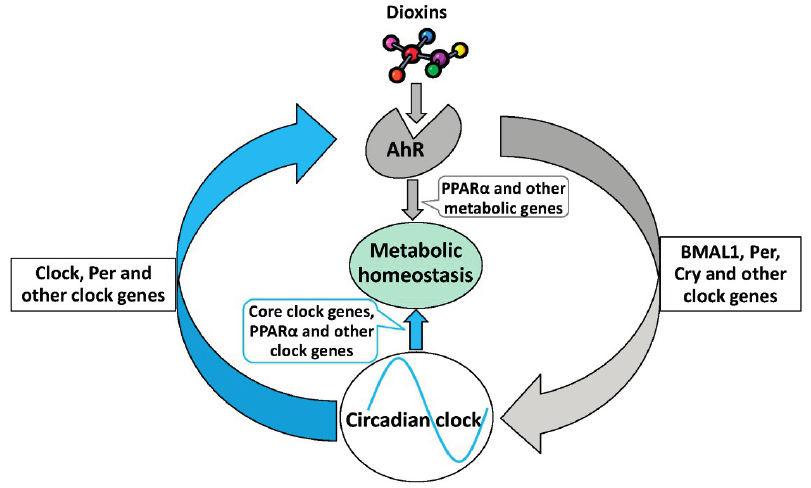
Figure 3. A simplified model depicting the crosstalk between dioxin-mediated AhR signaling and the circadian clock in metabolic homeostasis. Dioxin exposure and circadian clock disruption can both impair metabolic homeostasis through regulating the expression of core clock genes and metabolic genes displaying circadian rhythmicity. Dioxin-mediated AhR signaling disrupts clock function in the SCN and in peripheral tissues, but AhR is reciprocally regulated by the circadian